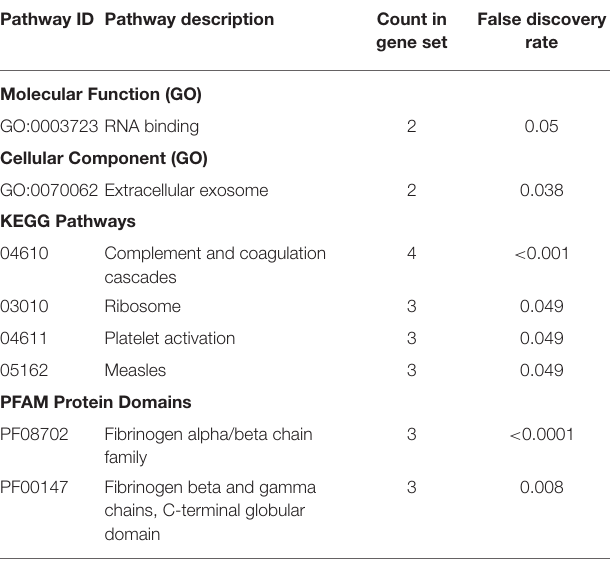
TABLE 4 | Significantly differentially expressed pathways in lamellar tissue of hyperinsulinemic horses. Pathway ID Pathway description